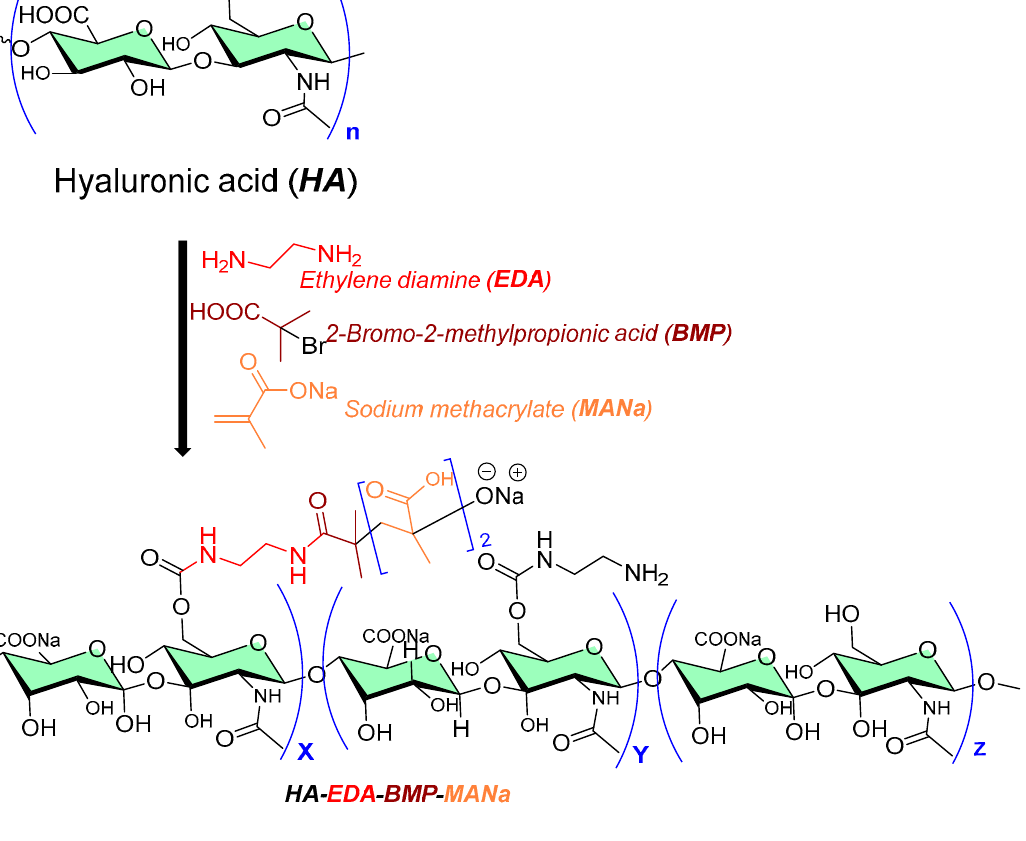
Figure 5. Chemical processing of hyaluronic acid copolymer as antibiofilm surface material.